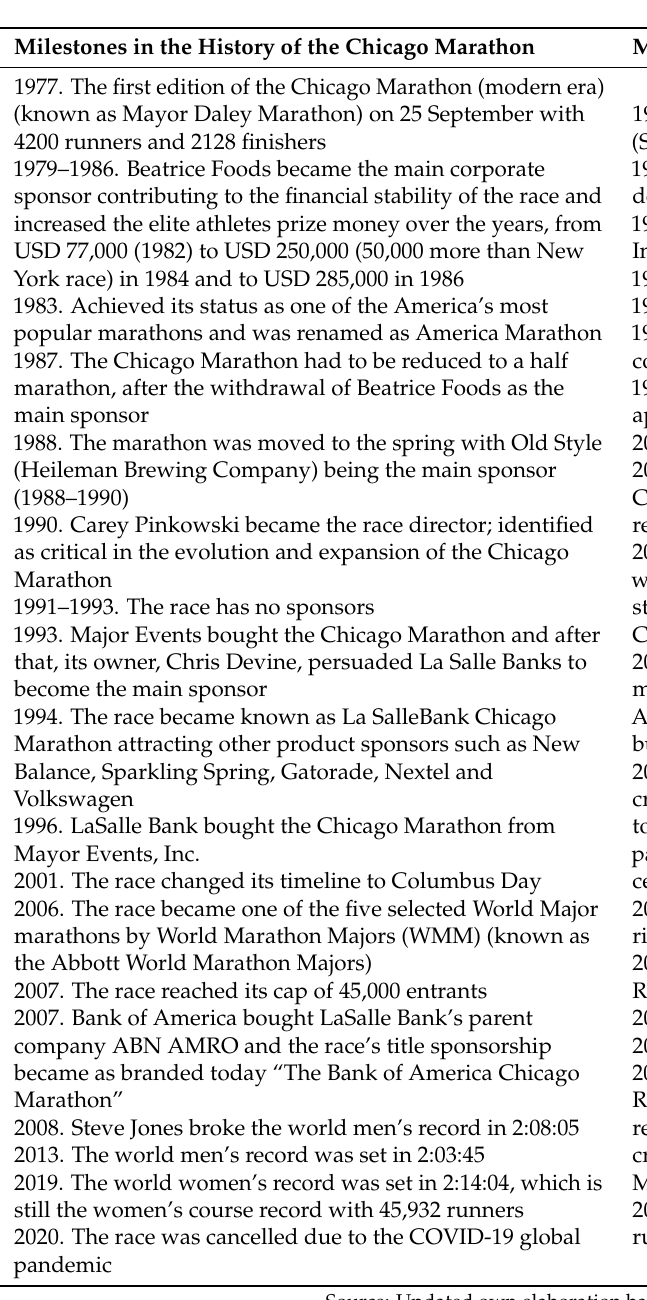
Table 1. Selected key decisions that explain the growth and evolution of the Chicago and Valencia